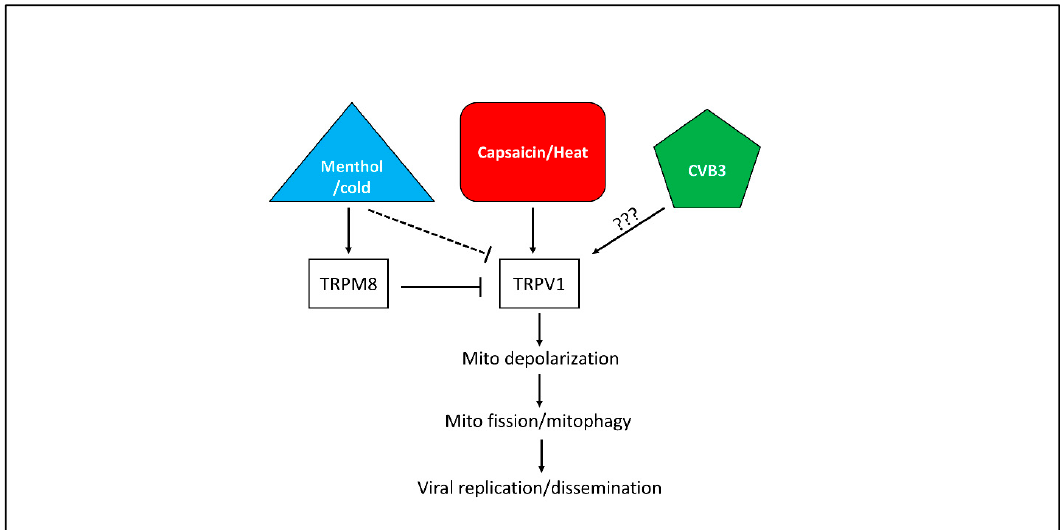
Figure 8. Hypothetical model of TRP channels and CVB infection- CVB has previously been shown to rely on mitochondrial fission and mitophagy to promote infection. Activity of the capsaicin and heat receptor TRPV1 appears to be important for CVB infection, and this may be due to its ability to cause mitochondrial depolarization and subsequent mitochondrial fission. It is unclear if CVB itself upregulates TRPV1 activity. The cold and menthol receptor TRPM8 antagonize TRPV1, thus menthol treatment indirectly suppresses TRPV1-mediated mitochondrial fission and blunts CVB infection.